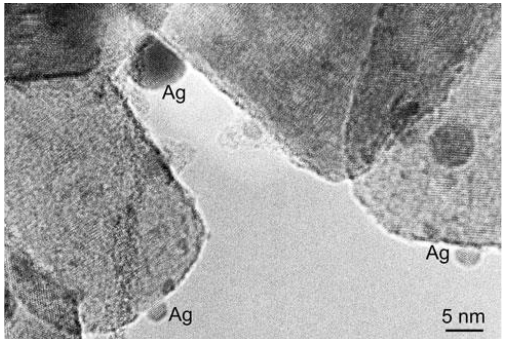
Figure 4. TEM micrograph of TiO 2 / Ag nanocomposite. Reprinted from ref. [31], Copyright (2012), with permission from Springer Nature.